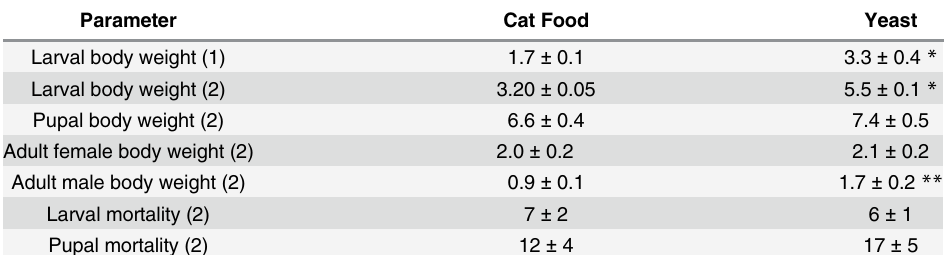
Table 1. Biological life parameters of Aedes aegypti raised on different diets. Cat food — insects fed on control diet. Yeast — insects fed on live S . cerevisiae cells. Weights are presented in mg and mortalities as